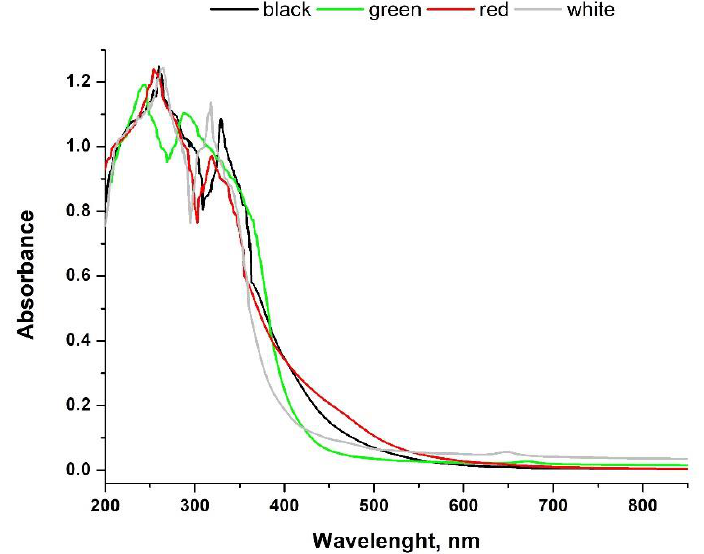
Figure 1. The UV-Vis spectra of examined teas: black, green, red and white.